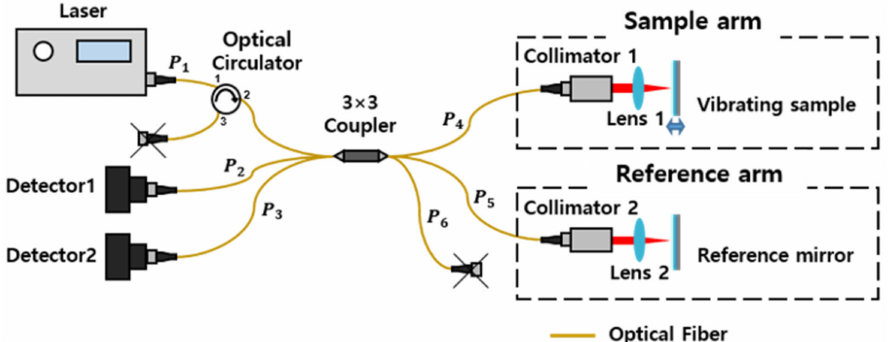
Figure 1. Schematic of a 3 × 3 optical interferometer system. The lights reflected at the sam- ple and the reference arms make interference at the coupler, which is then measured by two detectors